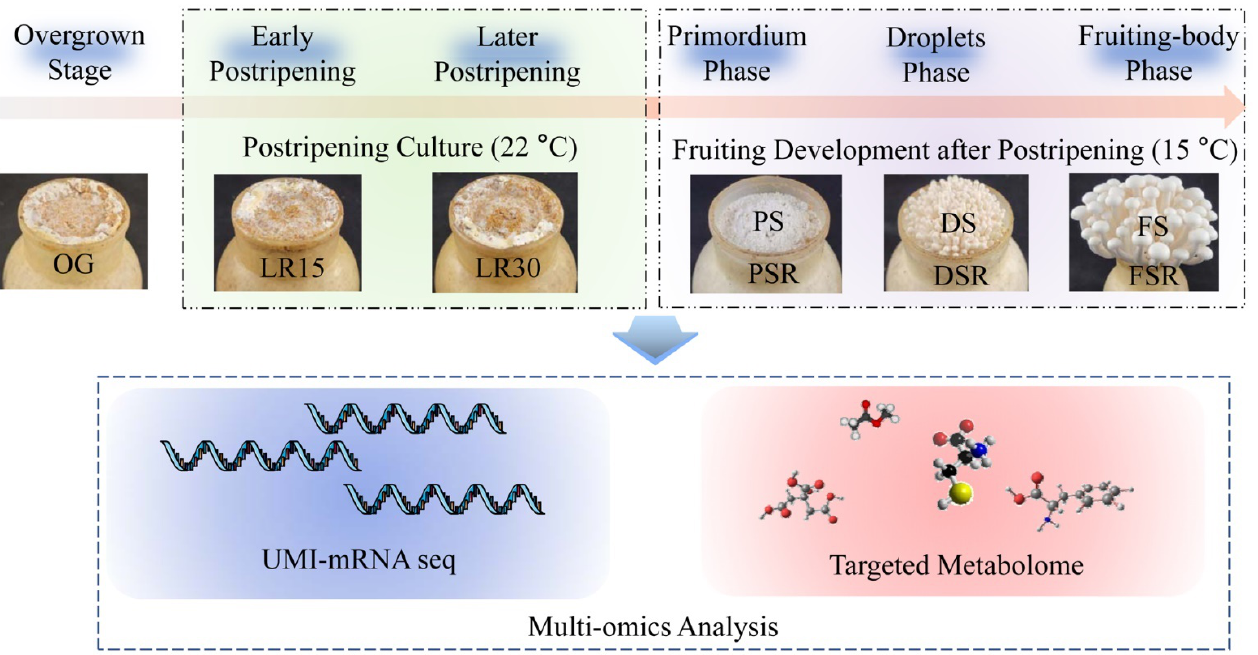
Figure 1. Flow chart of this study. Multi-omics analysis was used to analyze the gene and metabolite expression profiles of H. marmoreus at developmental stages to reveal the molecular mechanism of LFLP.